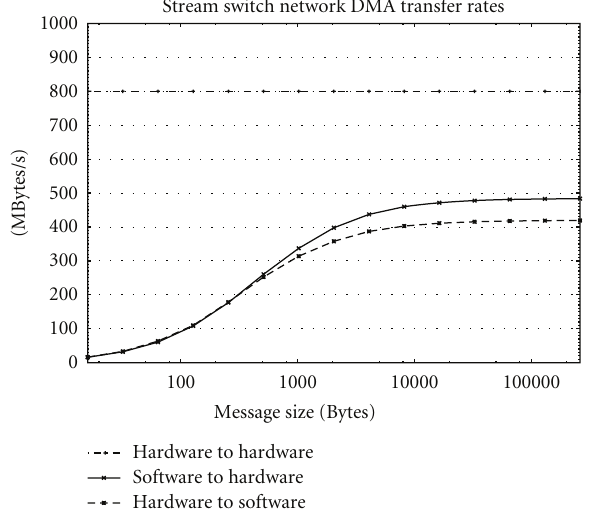
Figure 7: PowerPC BLAST system.